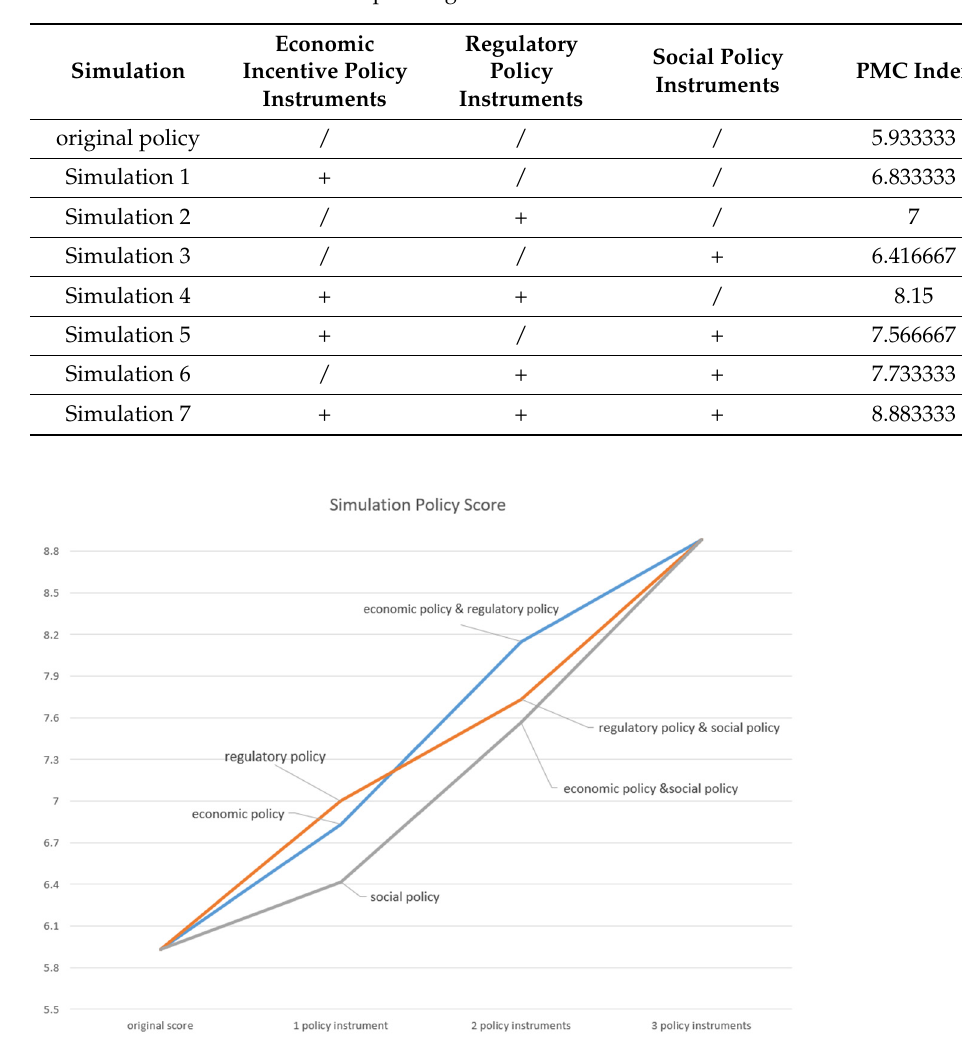
Table 6. The simulation and corresponding PMC index scores.